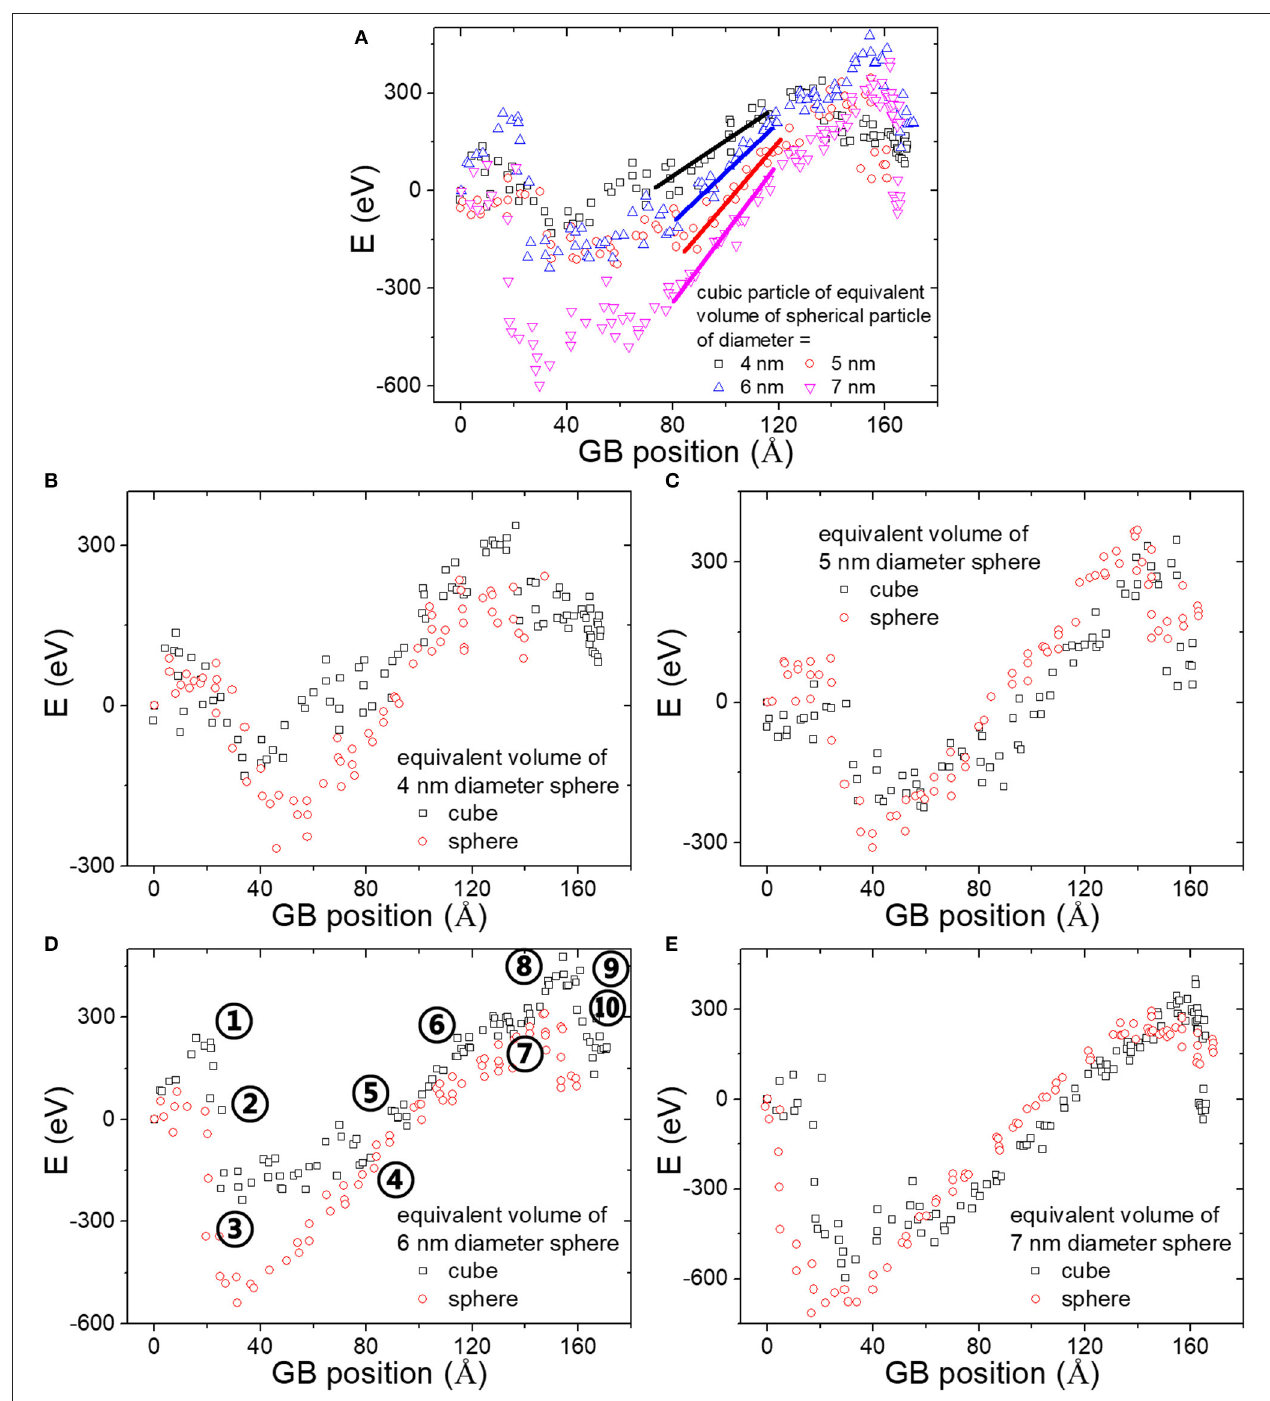
FIGURE 8 | (A) Energy vs. boundary position for the cubic particles. (B–E) Comparisons of the energy–position curves between the cubic and spherical particles. Indexes in (D) correspond to the ones given in Figure 6 .